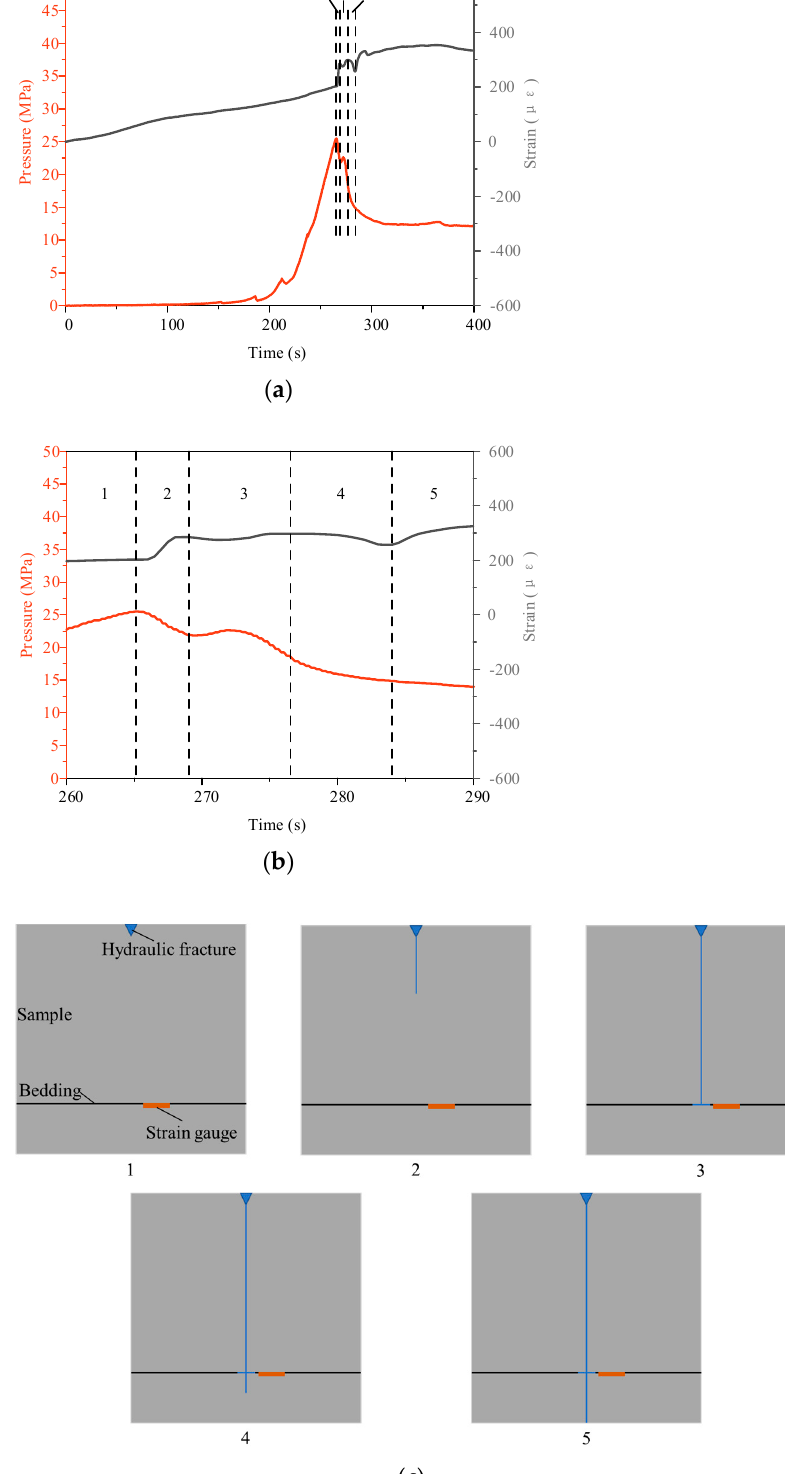
Figure 10. Pressure curve, strain curve and propagation diagram of CF-1 in Test 3: ( a ) pressure and strain curves; ( b ) local magnification of pressure and strain curves; ( c ) diagram of fracture propagation process.